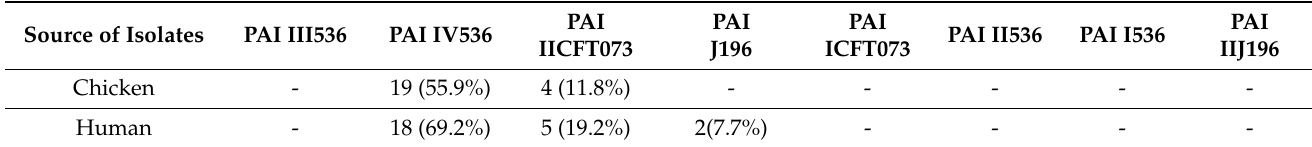
Table 2. Pathogenicity island (PAI) markers identified in E. coli isolates from chicken and